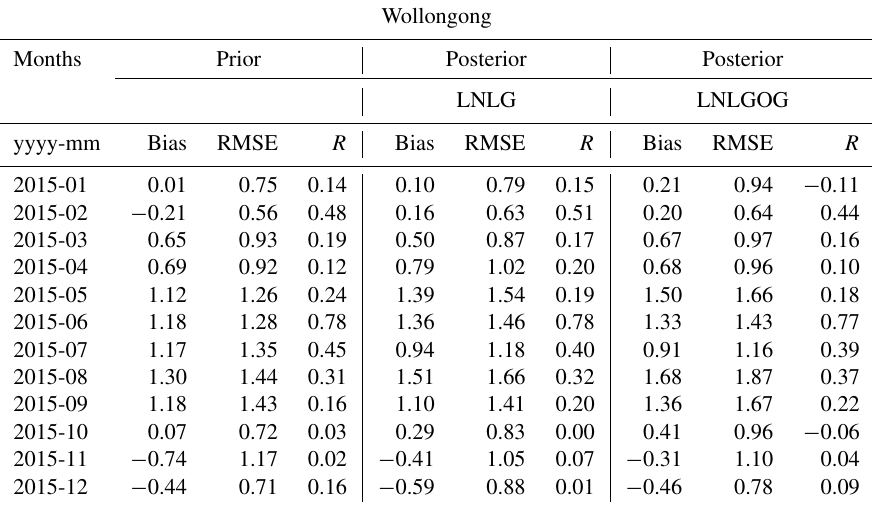
Table G3. Analysis of the residual between CMAQ prior and posterior simulations and the TCCON Wollongong ∗ site for 2015: averaged bias, RMSE and Pearson’s coefficient ( R